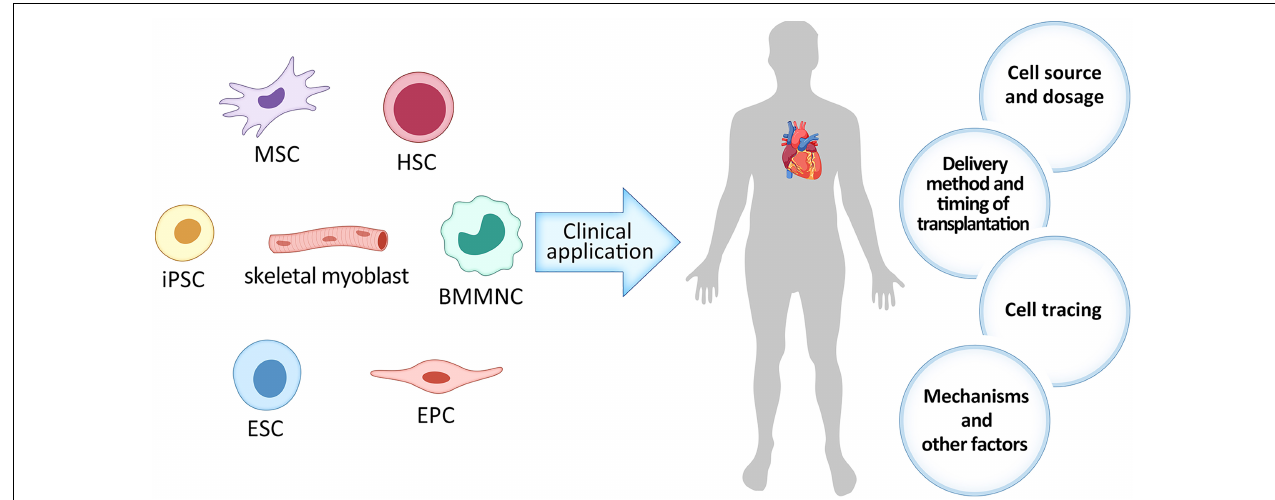
FIGURE 1 | The current dilemma with stem cell therapy in ischemic heart disease (IHD). MSC, Mesenchymal stem cell; iPSC, induced pluripotent stem cell; ESC, embryonic stem cell; EPC, endothelial progenitor cell; HSC, hematopoietic stem cell; BMMNC, bone marrow-derived mononuclear